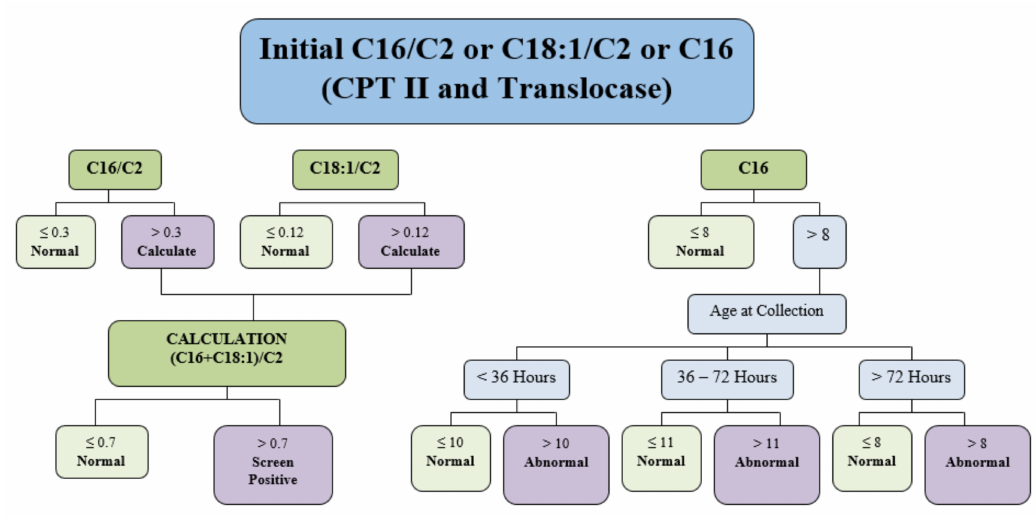
Figure 1. Algorithm used in 2014 for Newborn Screening for CPT II deficiency and CACT deficiency. The logic in this figure has since been updated. Currently, (C16 + C18:1)/C2 is the primary screening biomarker with a cut-off of >0.7 as screening positive. All acylcarnitine values are in µ mol/L.